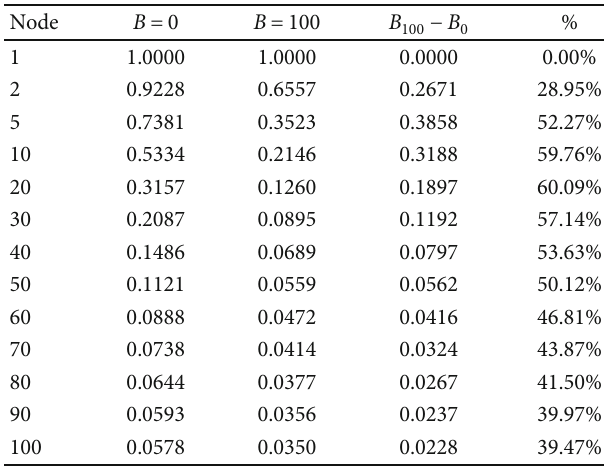
Table 3: Comparison of radiation values B = 60 . Node